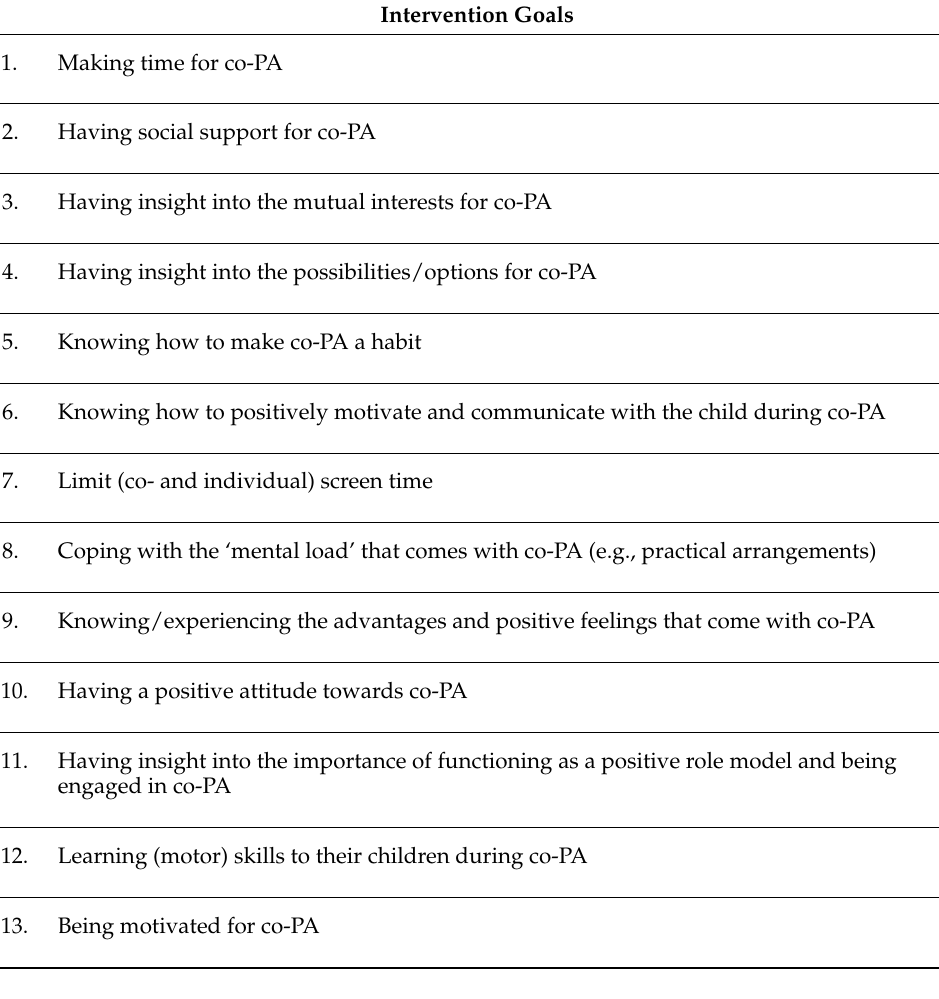
Table 3. Overview of the 13 intervention